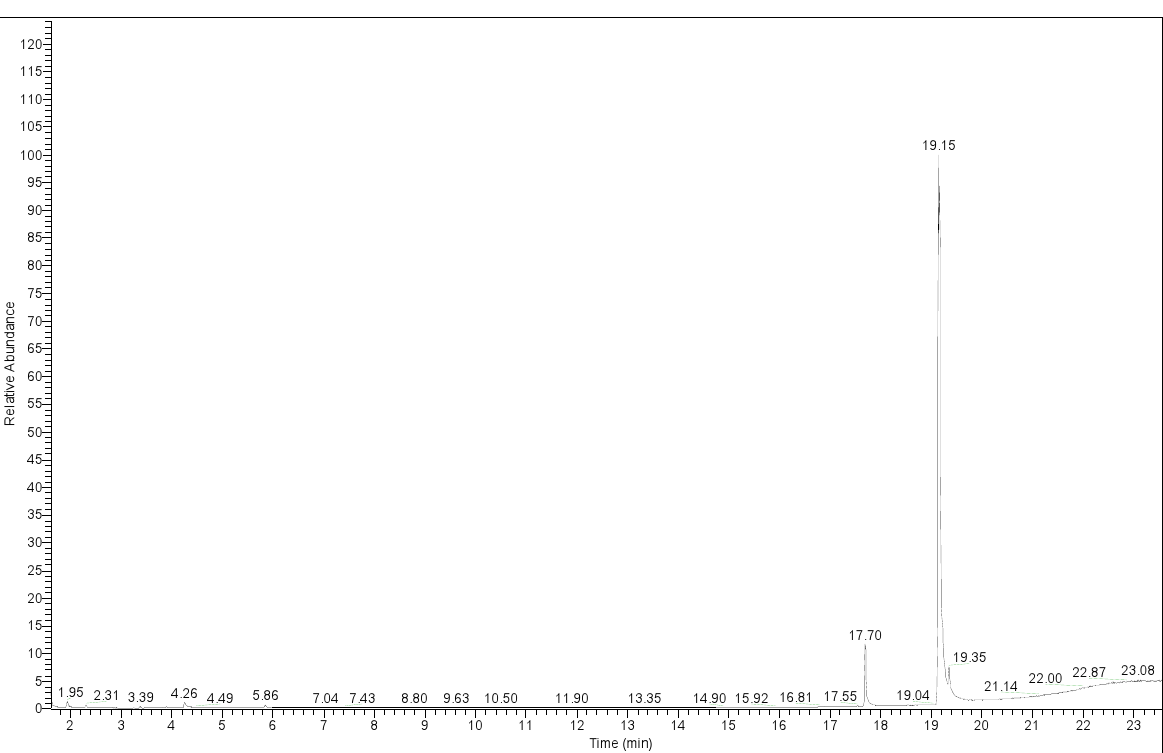
Figure 3. The chromatogram of the reaction mixture resulted from the esterification reaction in the case of B3 bioester.